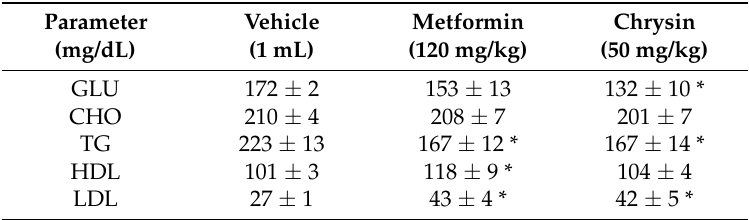
Table 1. Changes in blood parameters after ten days of treatment with chrysin. (*) variance of mean significance ≤ 0.05. GLU: glucose, CHO: cholesterol, TG: triglycerides, HDL: high density